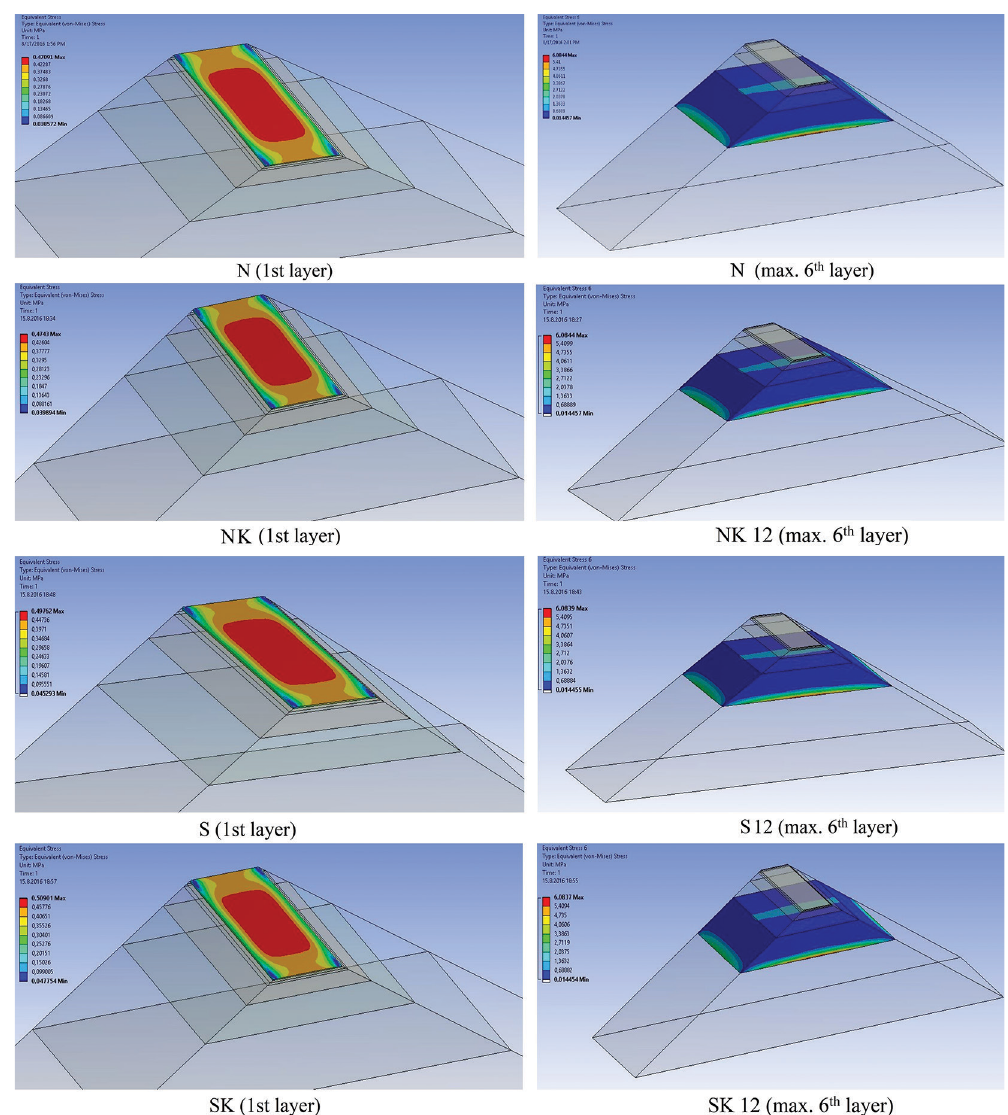
Figure 7. Von Mises Stresses on FEM models for the 1st layer (pavement) and max 6th